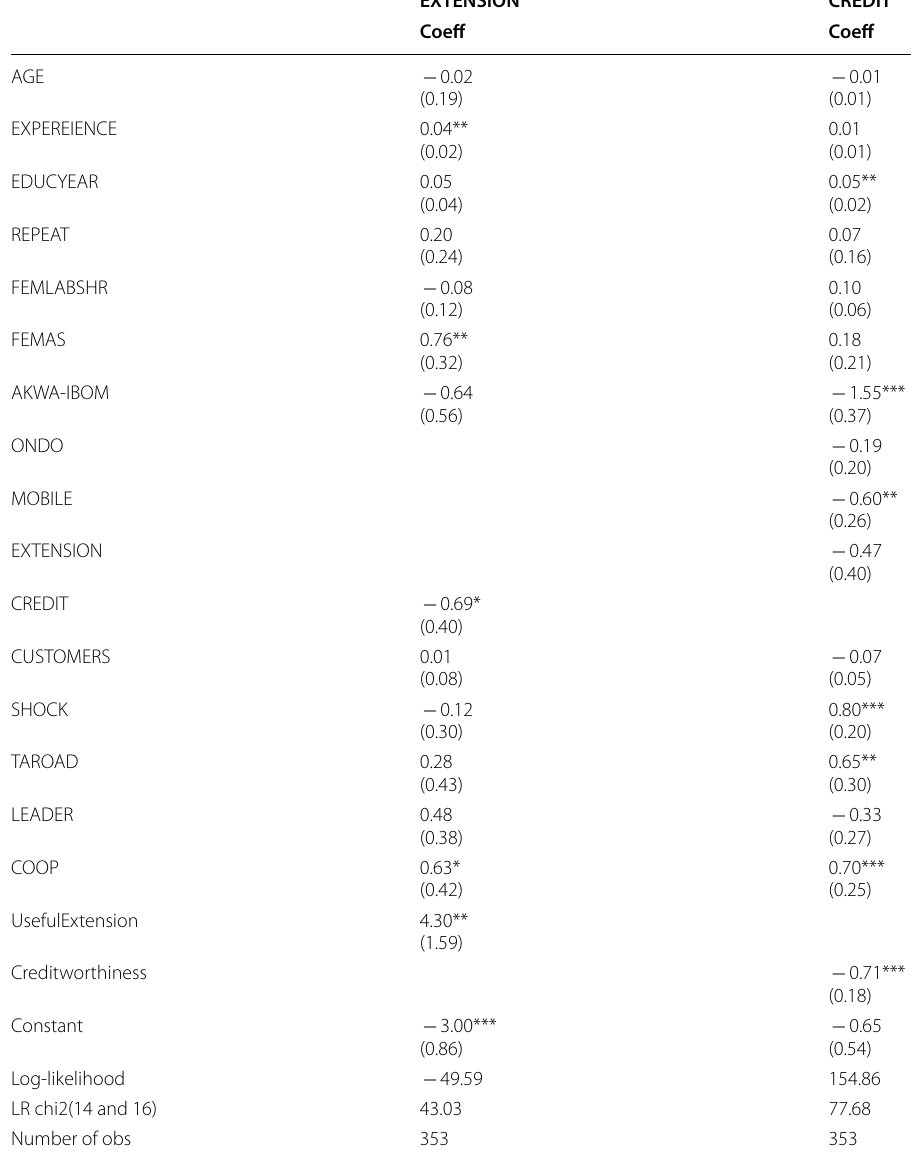
Table 10 Probit model addressing potential endogeneity (unmatched